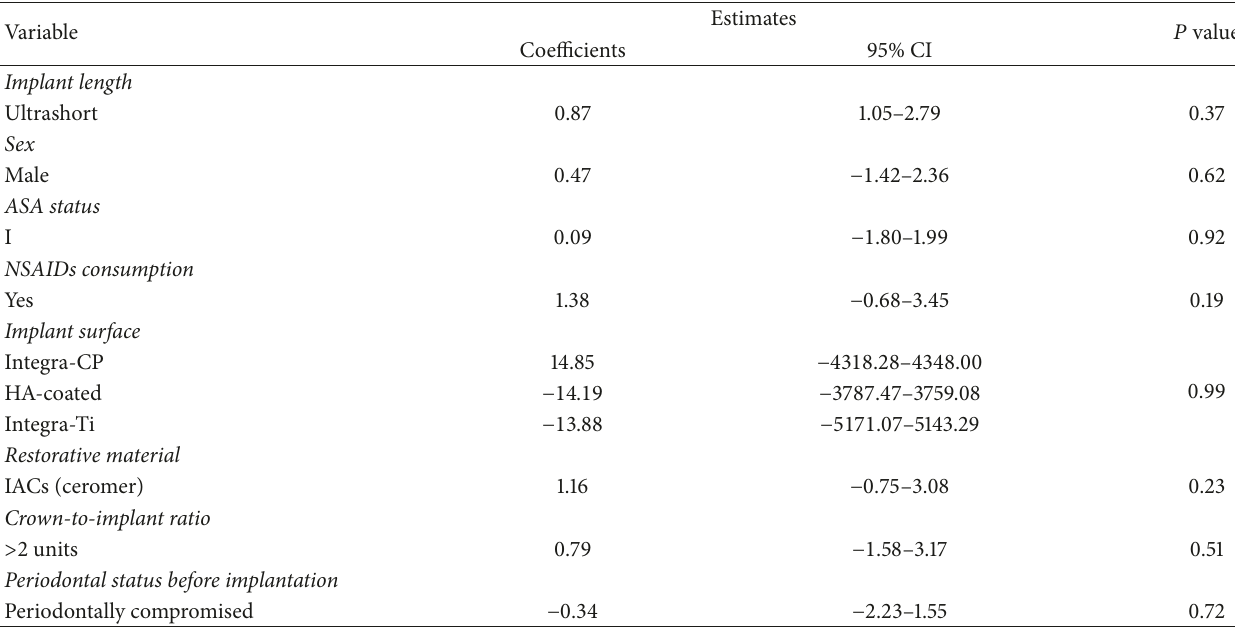
Table 4: Standardized coefficients derived from log-binomial regression and 95% confidence intervals for factors associated with success